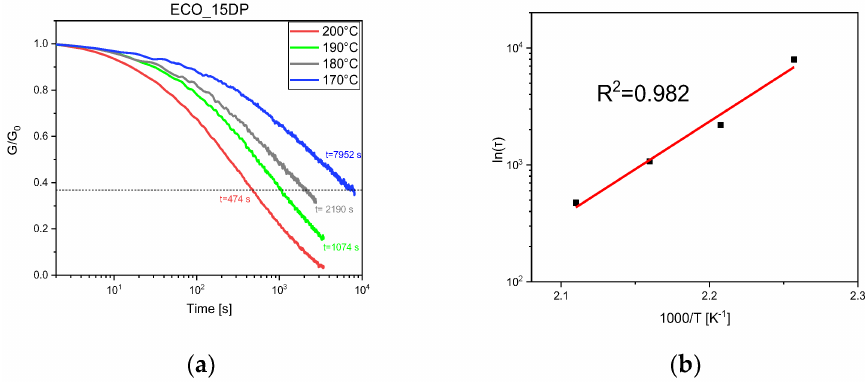
Figure 7. Stress relaxation at 170 ◦ C, 180 ◦ C, 190 ◦ C, and 200 ◦ C of UV-cured ECO samples with 10 phr DP ( a ) and related Arrhenius plots ( b ).